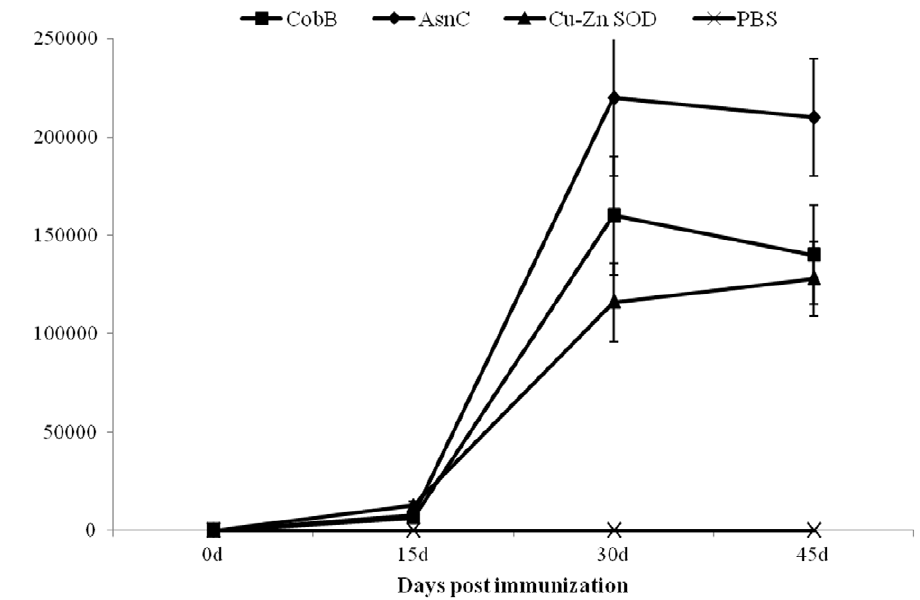
Figure 3. Humoral immune response induced by CobB, AsnC, and Cu-Zn SOD. BALB/c mice (n=5) were inoculated intraperitoneally with purified recombinant proteins plus adjuvant. At 0, 15, 30, and 45 days post the immunization, serum samples were collected and IgG antibody titers were determined by ELISA. The values are mean titers 6 SD of antibodies from the five mice. doi:10.1371/journal.pone.0029552.g003 PLoS ONE |